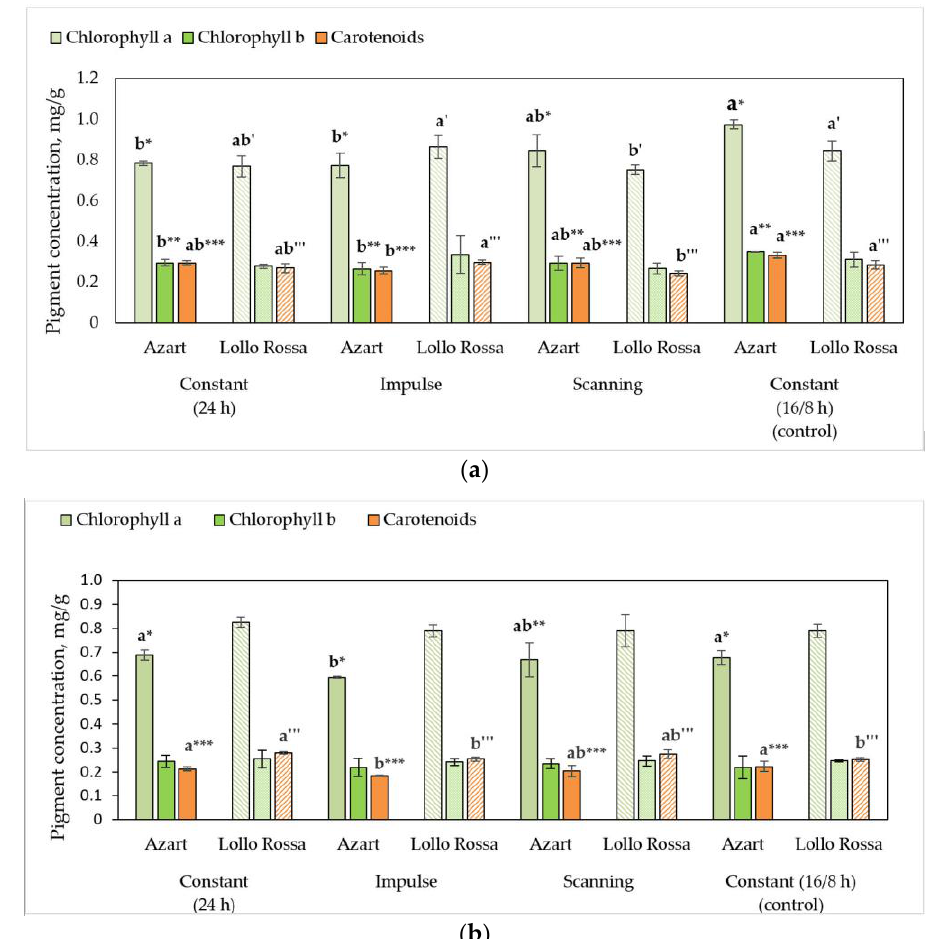
Figure 2. The concentration of pigments on the 25th ( a ) and 35th ( b ) day of cultivation. The solid colour indicates the columns of the diagram related to the ‘ Azart ’ variety; the shading columns of the diagram indicate data related to the ‘ Lollo Rossa ’ variety. Values represent mean SEM (n = 10). Letters indicate significant differences among treatment and control samples ( p < 0.05). Asterisk sign near letters is used for the ‘Azart' variety and apostrophe - for the 'Lollo Rossa' variety. One sign is used for Chlorophyll a , two signs − for Chlorophyll b and three signs − for Carotenoids.